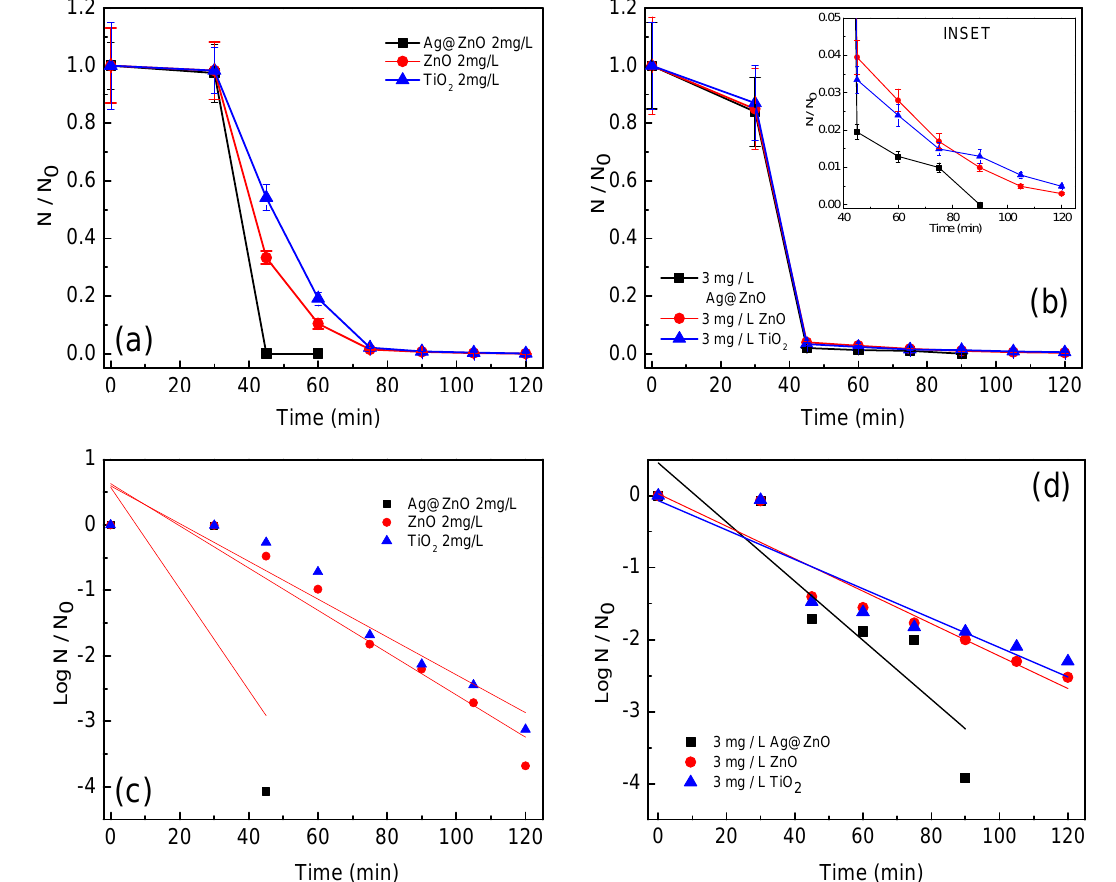
Figure 4. Effect of different catalysts on the solar-PCD kinetics of ( a ) E. coli and ( b ) S. aureus at a catalyst loading of 2 mg/L and 3 mg/L respectively. Linear fitting plots of PCD kinetics of different catalysts against ( c ) E. coli and ( d ) S. aureus according to Chick-Watson model at a catalyst loading. Initial bacteria concentration for each experiments = 5 × 10 6 CFU/mL, Temperature = 35 ± 2 ◦ C. Error bars indicate the standard deviation of replicates ( n = 3).